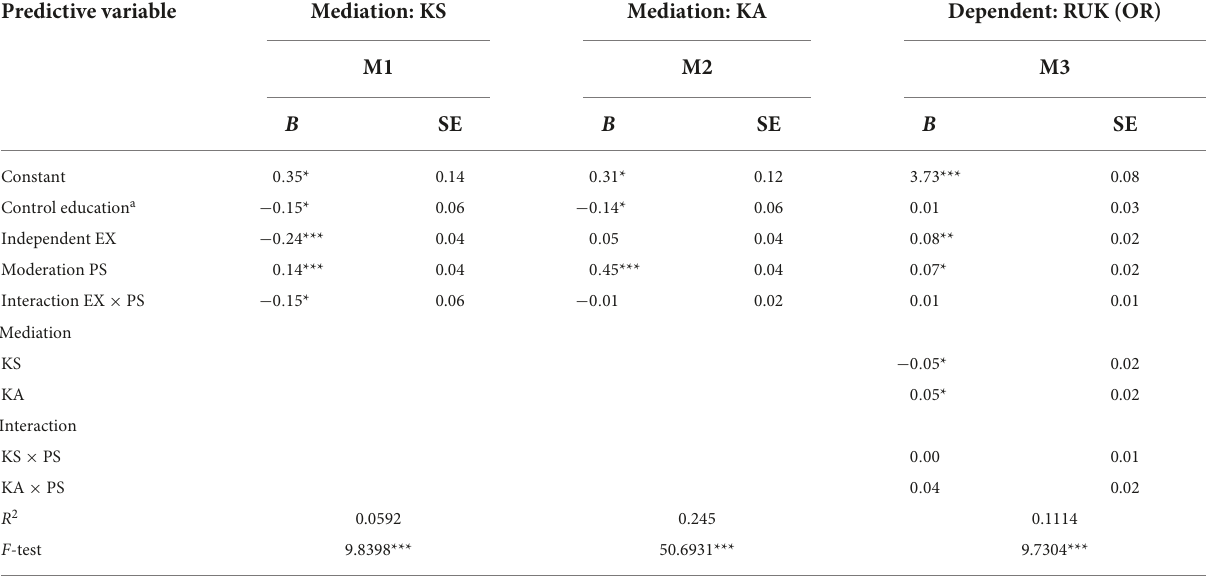
TABLE 4 Analysis of the moderating effect of political skills to experience on receiving useful knowledge